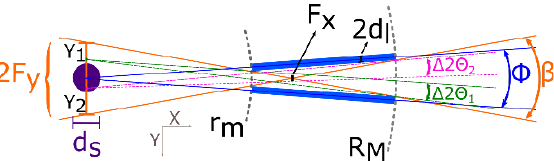
Fig. 2. Sight of the sample area by a single slit (blue radial blades) showing the main parameters defining the radial collimator: focal lines (orange), focal lengths F